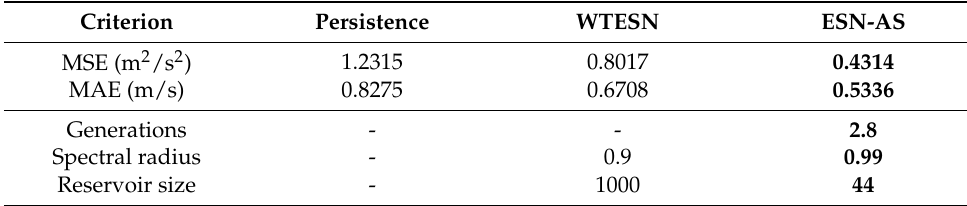
Table 6. Average test performance—MOS.